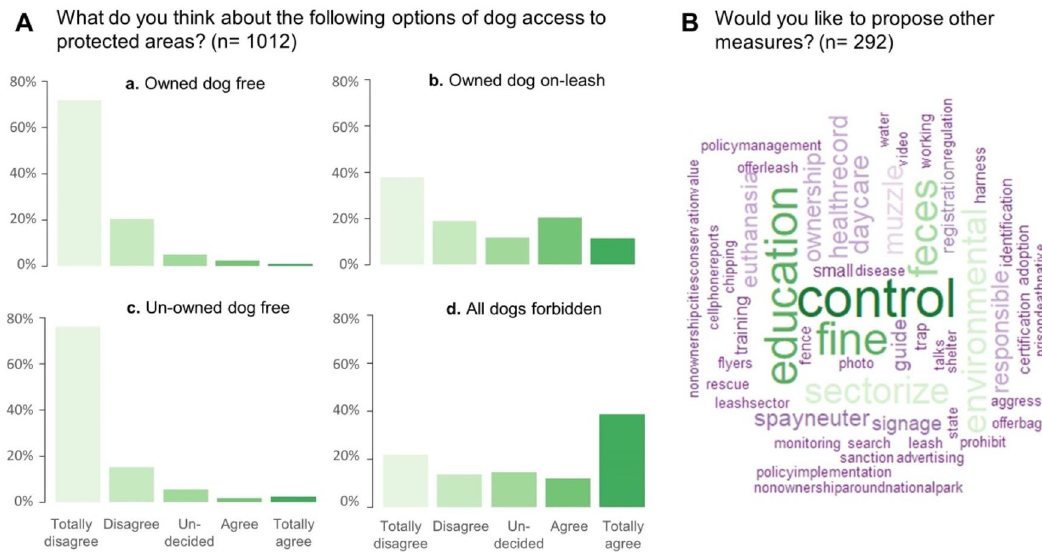
Figure 3. Relative frequencies of agreement with four proposed measures related to dog access to protected areas ( A ) and words that represent the other measures they proposed ( B ); the larger the words the more respondents who proposed this